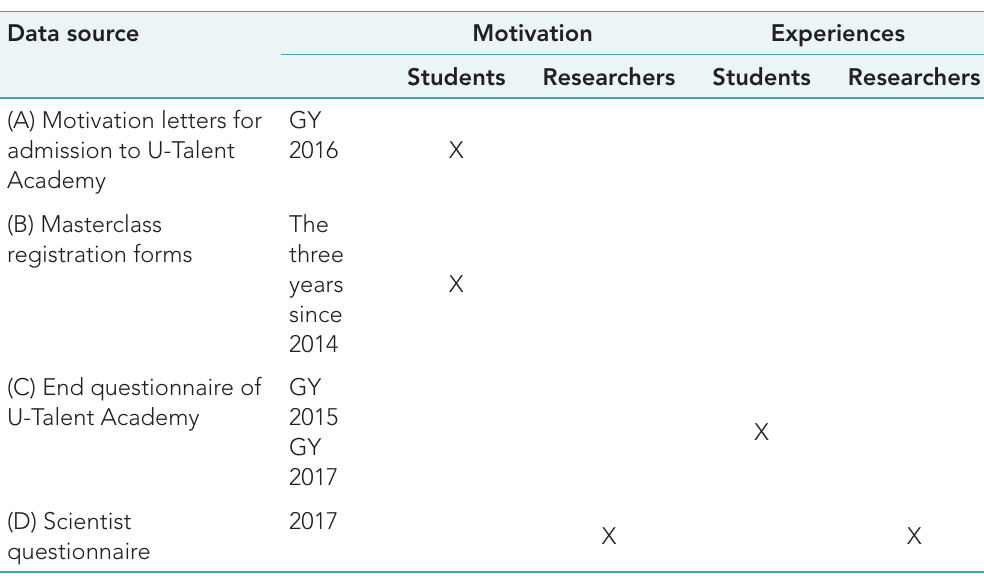
Table 2: Data sources analysed Data source